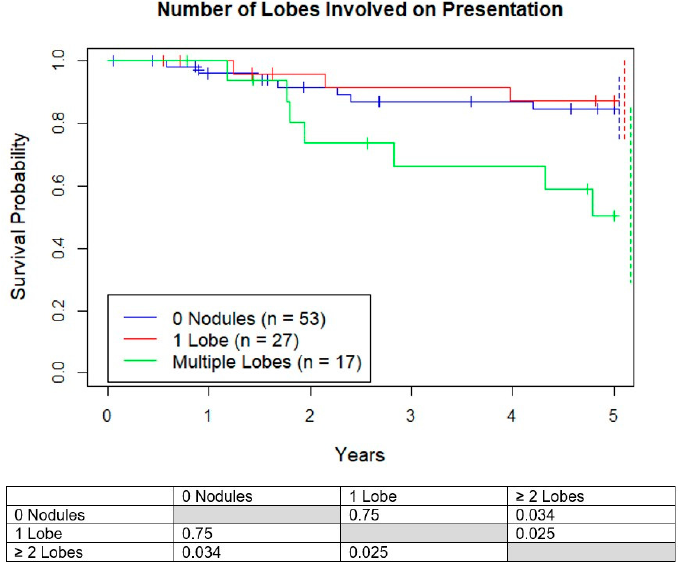
Figure 5. Kaplan–Meier curves demonstrating survival probability vs. years. Groups are separated by number of lobes with lung nodules < 10 mm on presentation. Dotted lines represent 95% confidence intervals for respective color.